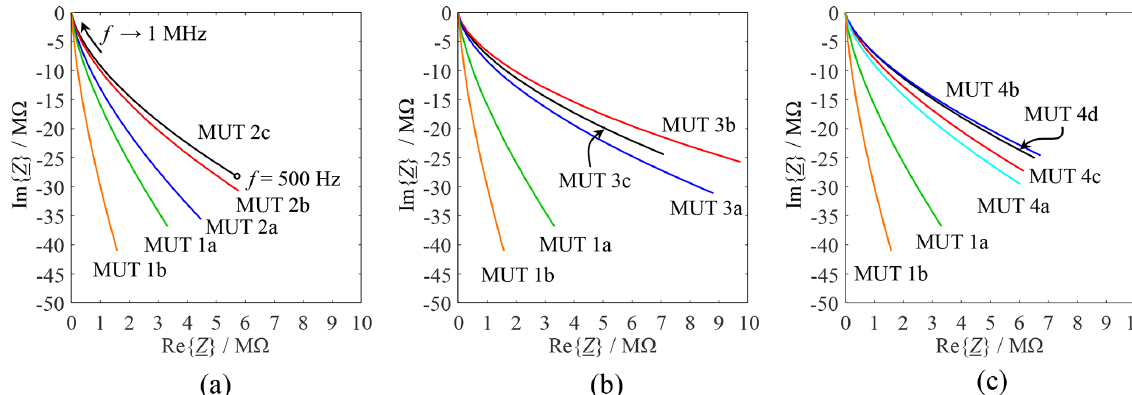
Figure 6. Nyquist curves of measurement-cell impedances with new and old quartz sand (a–c) , quartz sand–carbon mixtures (a) , quartz sand–bentonite mixtures (b) , and quartz sand–carbon–bentonite mixtures (c) in the frequency range from 500Hz to 1MHz.